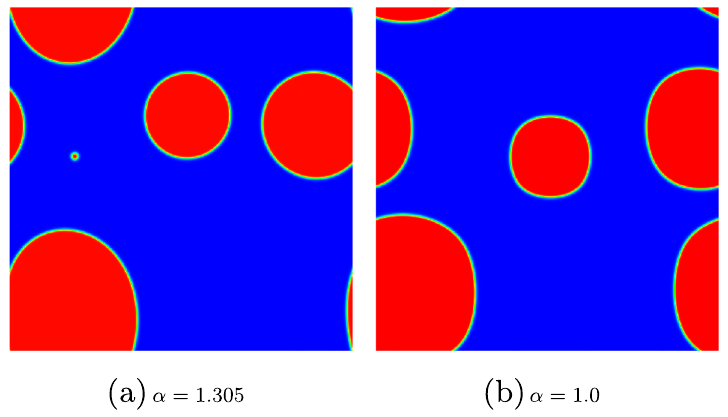
Fig. 16 Snapshots of the spinodal decomposition process, τ = 0.3 , T r = 0.8 , t = 40000